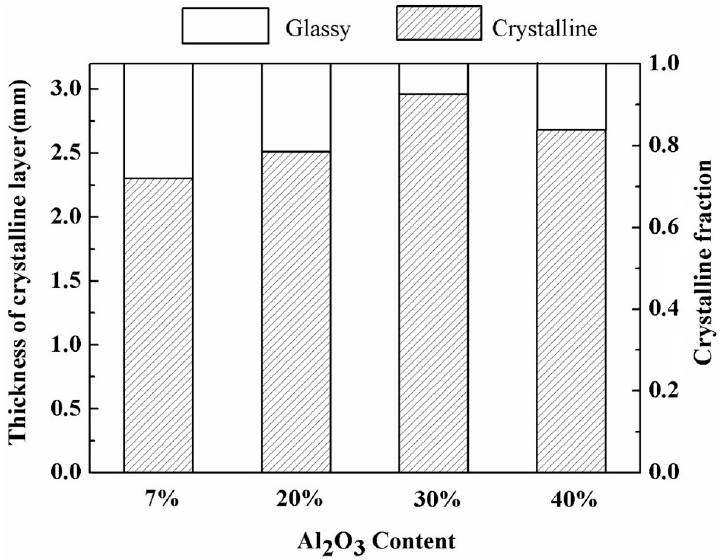
Figure 12. Thickness of the crystalline layer and the crystalline fraction of disks with different amounts of Al 2 O 3 . of Al 2 O 3